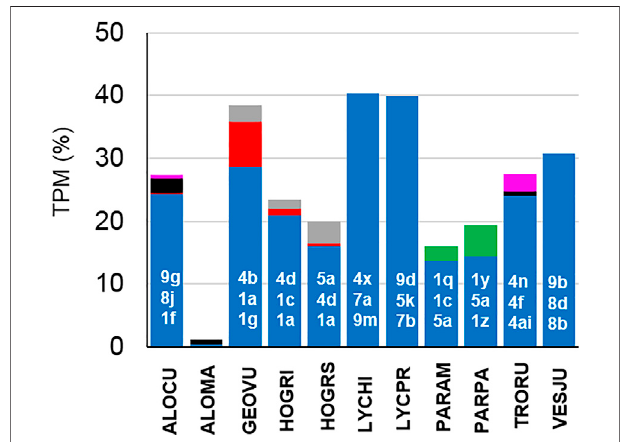
FIGURE 13 | Comparison of the frequency of occurrence of LP families in lycosids species. Lycosin families are colored in blue, pardosins in green, trochosinsinpink,hogninsingray,andgeolycosinsinred.Individualmembers of the three most abundant lycosin families [highest Transcripts Per Kilobase Million (TPM) values] are given in white numbers ( Supplementary Table S7